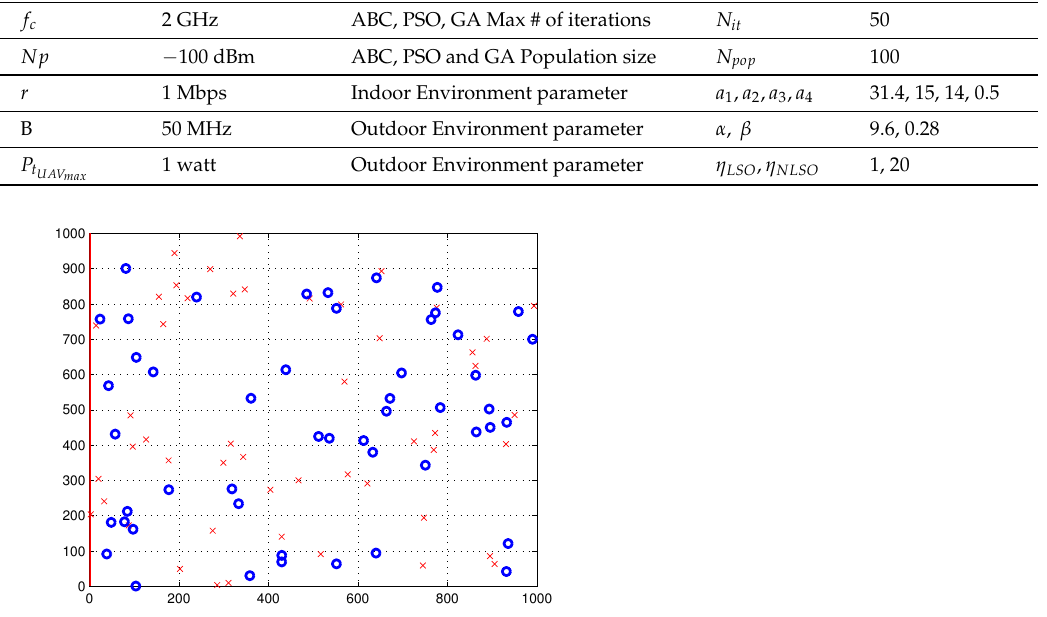
Figure 5. Uniformly distributed outdoor and indoor users inside S , denoted as blue circles and red crosses, respectively.